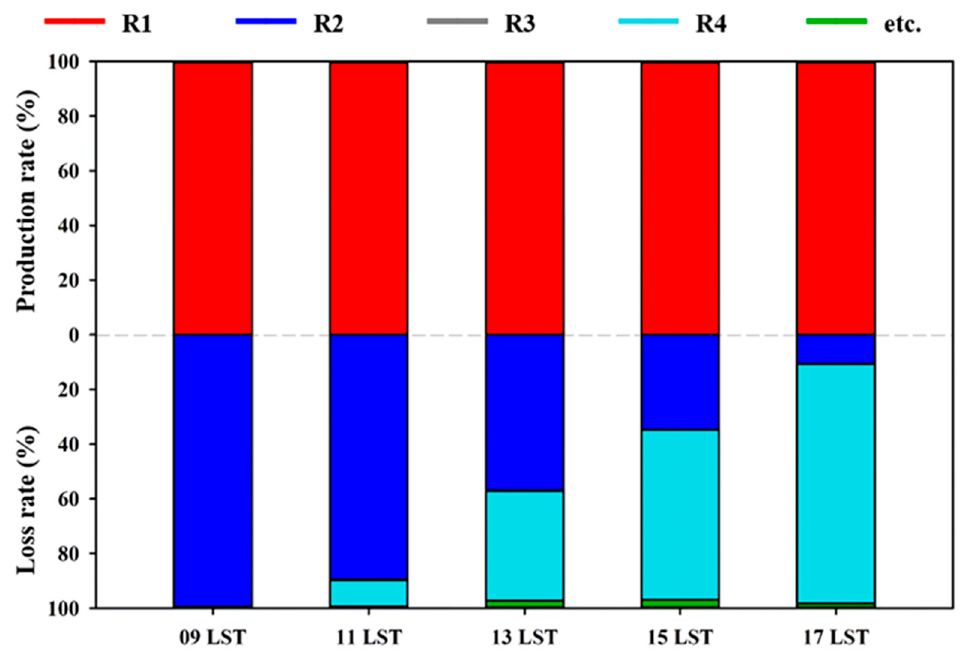
Figure 9. Percentage contribution of chemical reactions to the production and loss of O 3 during the analysis period. analysis